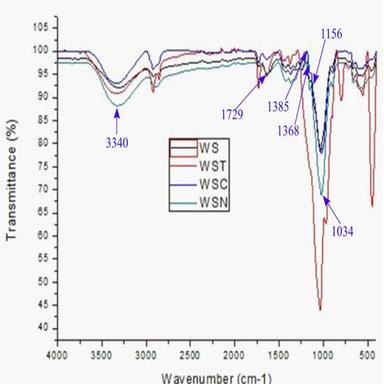
FTIR spectra of wheat straw: (a) untreated, (b) bleached, (c) alkali treated and (d) nanocellulose.